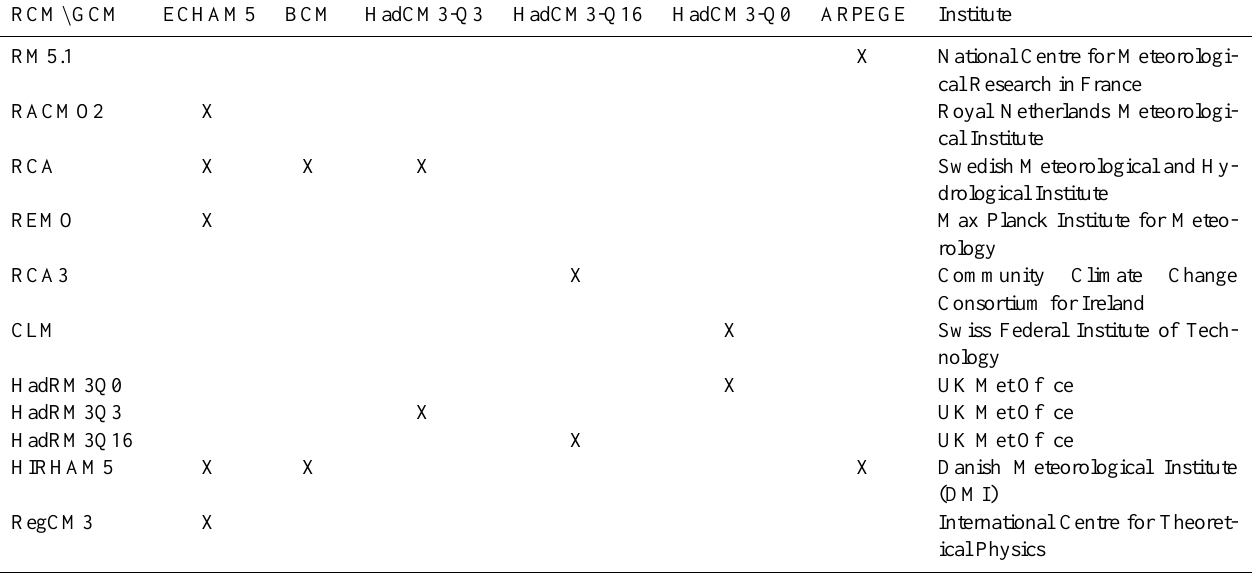
Table 2. Matrix of RCM–GCM combinations used in this study and source of the RCMs. RCM \ GCM ECHAM5 BCM HadCM3-Q3 HadCM3-Q16 HadCM3-Q0 ARPEGE RM5.1 RACMO2 X RCA X X REMO X RCA3